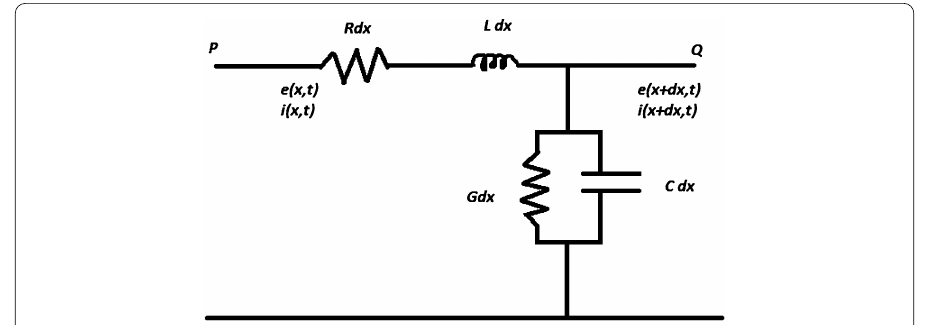
Figure 1 Telegraph wire with